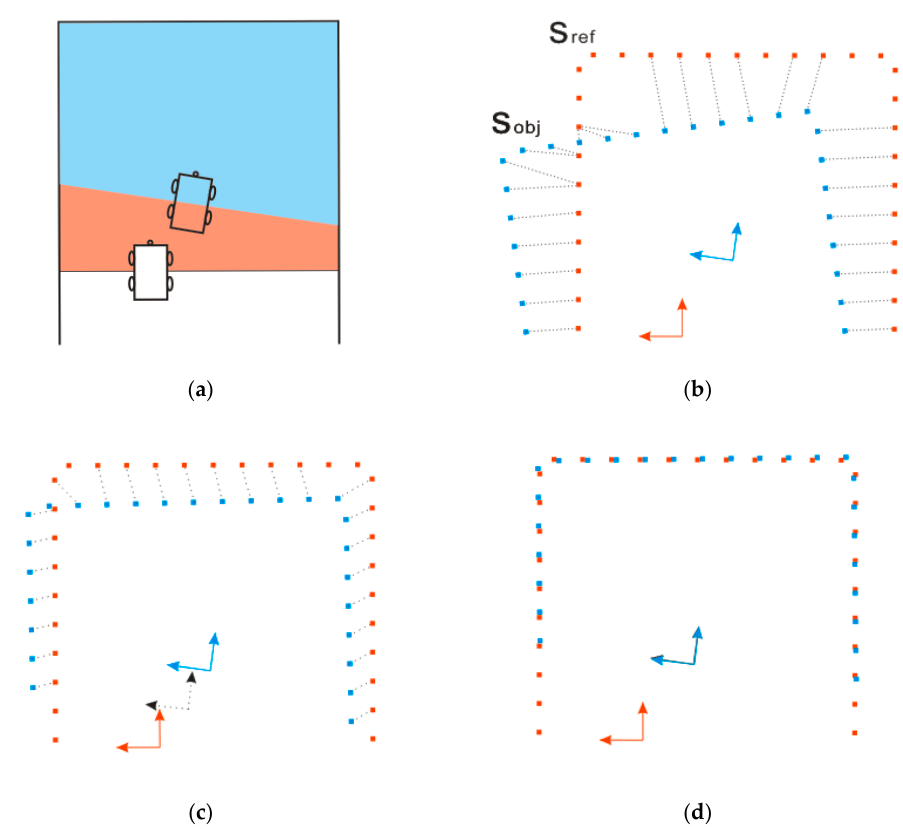
Figure 1. ( a ) Two laser scans that were taken at times (cid:1872) (cid:2869) and (cid:1872) (cid:2870) ; ( b ) object scan (cid:1845) (cid:3042)(cid:3029)(cid:3037) (blue) that was taken at (cid:1872) (cid:2870) is represented in the coordinate system of the reference scan (cid:1845) (cid:3045)(cid:3032)(cid:3033) (red), and the dotted lines are the correspondences based on the criterion of the closest point; ( c ) (cid:1845) (cid:3042)(cid:3029)(cid:3037) (blue) is brought closer to (cid:1845) (cid:3045)(cid:3032)(cid:3033) (red) as the iterations progress; ( d ) (cid:1845) (cid:3042)(cid:3029)(cid:3037) (blue) closely fits to (cid:1845) (cid:3045)(cid:3032)(cid:3033) (red) at the end of the iteration